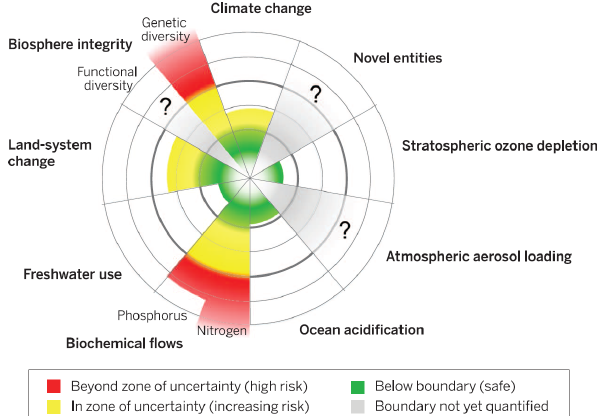
Figure 1. According to the latest revision of the PB framework, humanity is still “in the green” with regard to freshwater use; from Steffen et al. (2015), reprinted with permission from